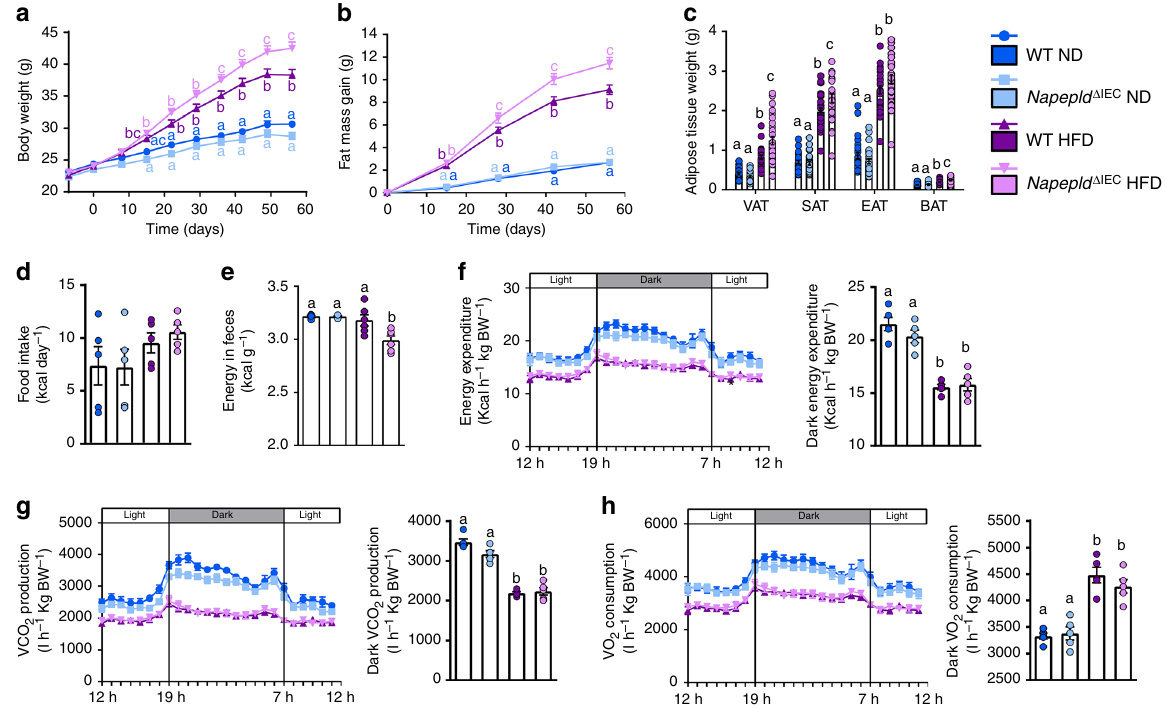
Fig. 4 Exacerbation of HFD-induced obesity in Napepld Δ IEC mice. a Body weight (g) over an 8 weeks period. b Fat mass gain (g) over an 8 weeks period. c Weight of different white adipose tissue depots and BAT (g). d Daily food intake (Kcal/day) measured in metabolic chambers during indirect calorimetry studies at the 8th week of HFD feeding. e Energy measured in the feces at the 8th week of HFD feeding (Kcal g feces − 1 ). f Light and dark cycle energy expenditure (Kcal h − 1 Kg body weight − 1 ) measured in metabolic chambers. g Light and dark cycle of CO 2 production (l h − 1 Kg body weight − 1 ). h Light and dark cycle of O 2 consumption (l h − 1 kg body weight − 1 ). Data in a – c correspond to the results of three independent experiments. For a – c , n = 26 – 28. For d , f – h , n = 5. For e , n = 4 – 6. Dark blue: WT ND mice, light blue: Napepld Δ IEC ND mice, purple: WT HFD mice and pink: Napepld Δ IEC HFD mice. Data are presented as the mean ± s.e.m. Data with different superscript letters are signi fi cantly different ( P < 0.05) according to repeated measures two-way ANOVA followed by Tukey ’ s post-hoc test ( a , b ) or regular two-way ANOVA followed by Tukey ’ s post-hoc test ( c , h